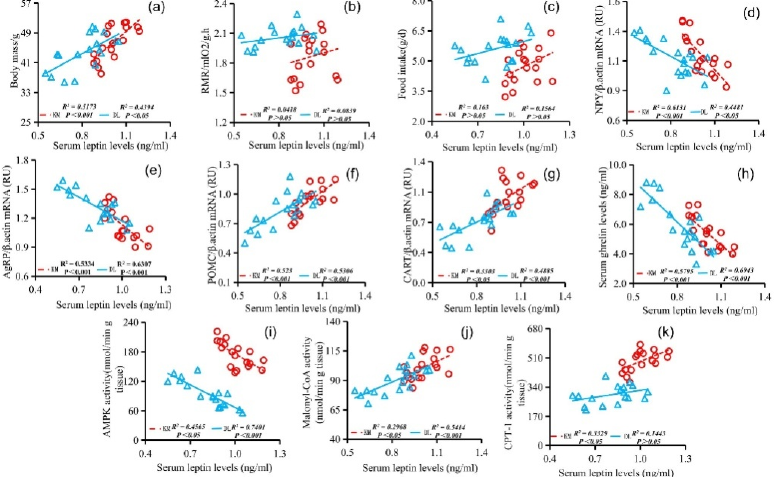
Figure 6. Correlation between serum leptin concentration and body mass ( a ), RMR ( b ), food intake ( c ), NPY gene expression ( d ), AgRPgene expression (e), POMC gene expression ( f ), CART gene expression ( g ), serum ghrelin concentration ( h ), AMPK activity ( i ), malonyl CoA activity ( j ), and CPT-1 activity ( k ) in E. miletus under food restriction.